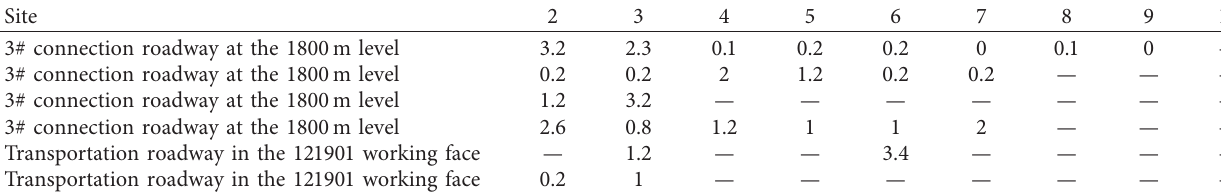
Table 8: Initial critical value of gas desorption index K